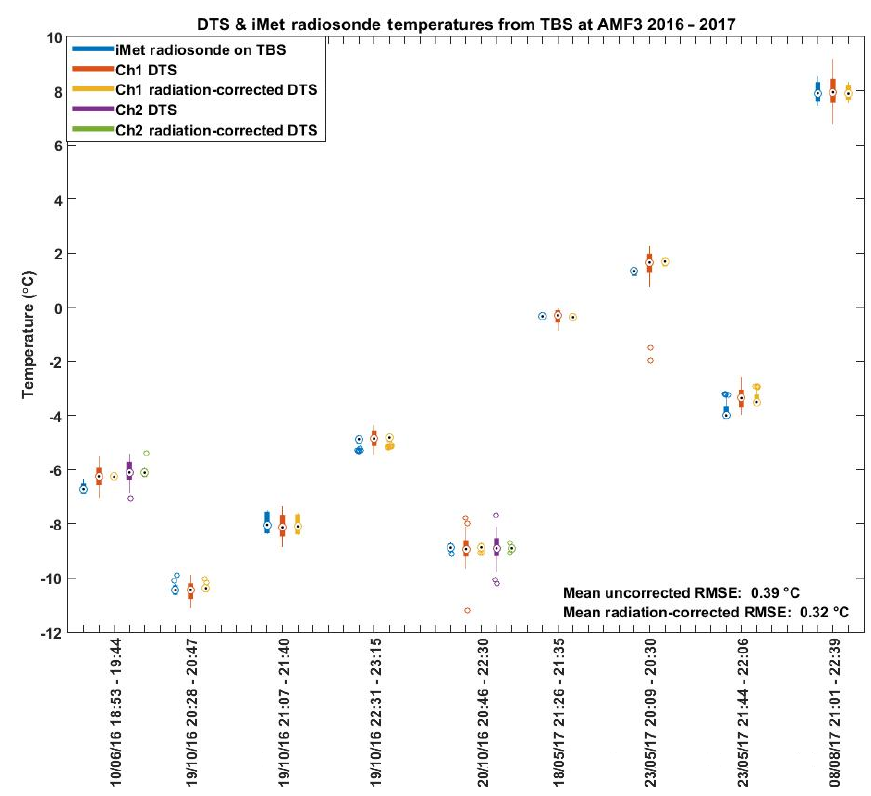
Figure 16. DTS and iMet radiosonde temperatures at matching altitudes from nine TBS flights at the AMF3 from 2016 to 2017. Table 3. Correlation coefficients and RMSEs for iMet-1-RSB radiosonde or iMet XQ2-calibrated DTS data, and DTS data collected with or without a fiber optic rotary joint